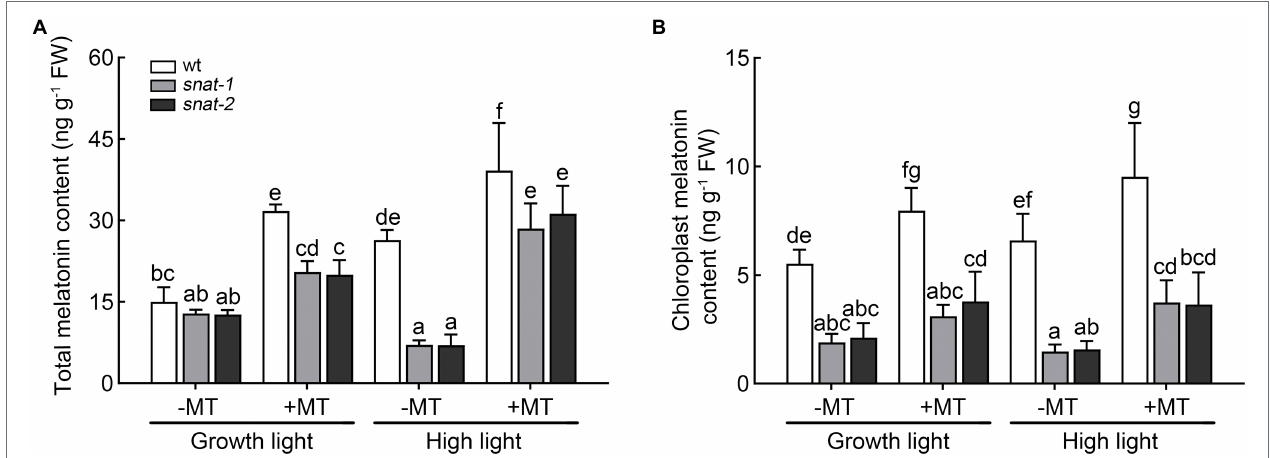
FIGURE 1 | Effects of exogenous melatonin on the content of melatonin. (A) The melatonin content in leaves. (B) The melatonin content in chloroplasts. Data represent means ± SDs of three replicate samples. Different letters denote significant differences (Tukey’s HSD post hoc test; p <